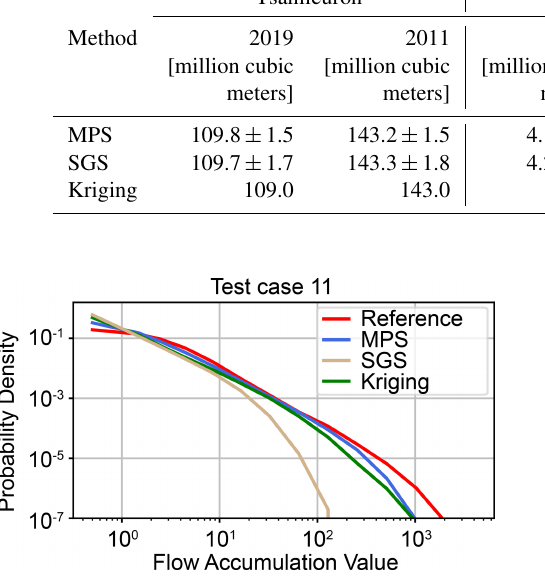
Figure 7. Probability distributions of flow accumulation values for example realization 11. The probability distribution of flow accu- mulation for the true DEM is compared to an example MPS simula- tion, kriging map, and SGS simulation. The corresponding Jensen– Shannon divergences with respect to the true distribution are 0.015 (MPS), 0.228 (kriging), and 0.107